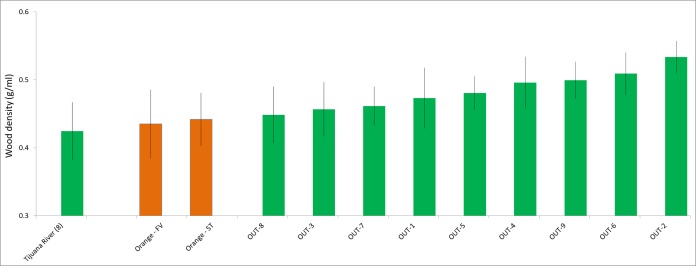
Inclusion of two intermediates.The density (g/ml) of arroyo willow branch samples collected at two Orange County sites (center) compared to densities collected at the polluted Tijuana River sites (left) and the less polluted San Diego County sites (right). FV, Fairview Park; ST, South Talbert Regional Park. Data are mean ± 1 std. dev.